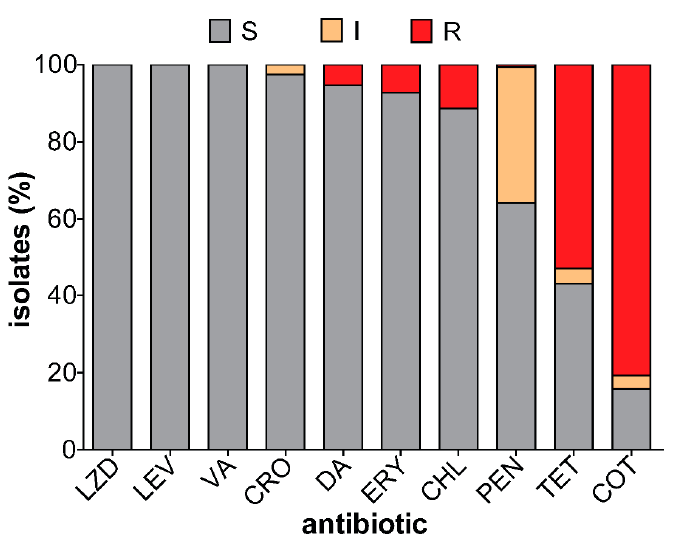
Figure 2. Antibiotic susceptibility patterns of pneumococcal isolates. Linezolid (LZD), Levofloxacin (LEV), Vancomycin (VA), Ceftriaxone (CRO), Clindamycin (DA), Erythromycin (ERY), Chloramphenicol (CHL), Penicillin (PEN), Tetracycline (TET), Cotrimoxazole (COT). S: susceptible (grey color), R: resistant (red color), I: intermediate resistance (orange color).